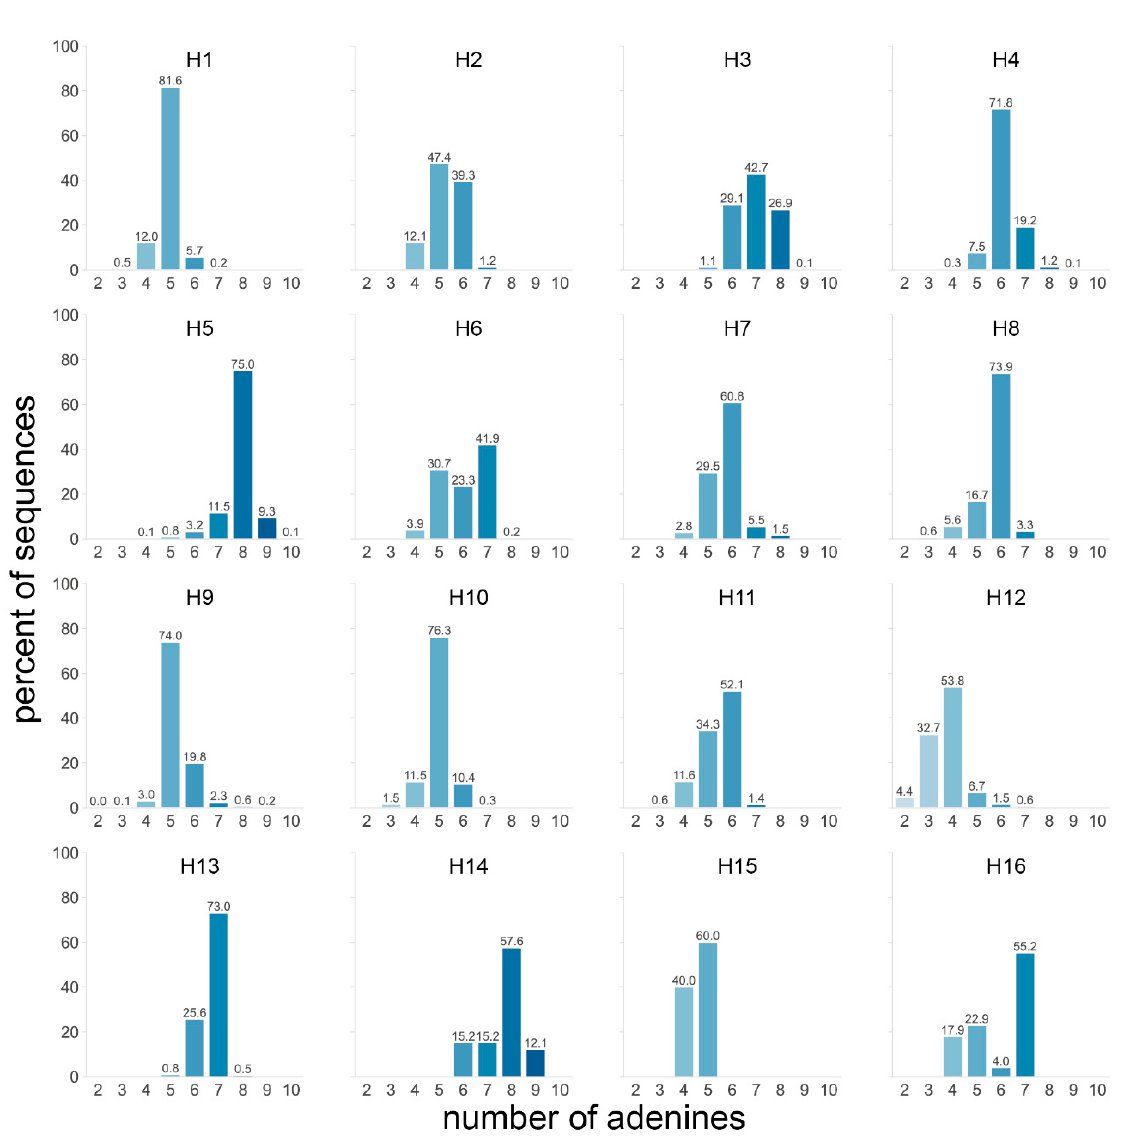
Figure 4. Number of adenines in the P4 to P1 HA cleavage site region for each subtype. The number of adenines in the 4 codons preceding the HA cleavage site was counted in each sequence, and the percentage of sequences with a given number of adenines was calculated independently for each subtype. A darker shade of blue indicates a higher number of adenines, and the exact percentages are indicated above each bar.